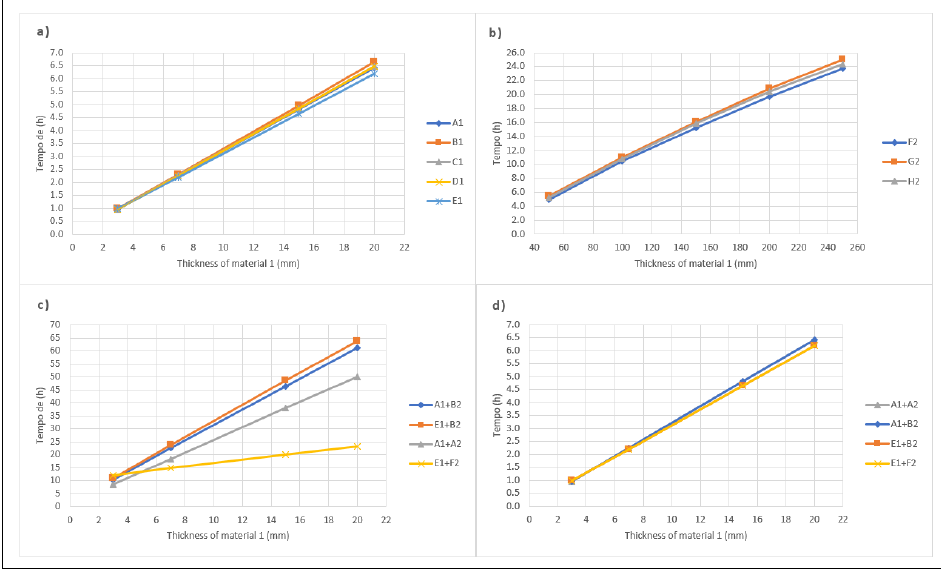
Figure 7. Cooling time for different thicknesses and configurations. ( a ) metallic materials (configuration I); ( b ) ceramic materials (configuration I); ( c ) material composition (configuration II); and ( d ) material composition (sidewall pivoting III configuration).